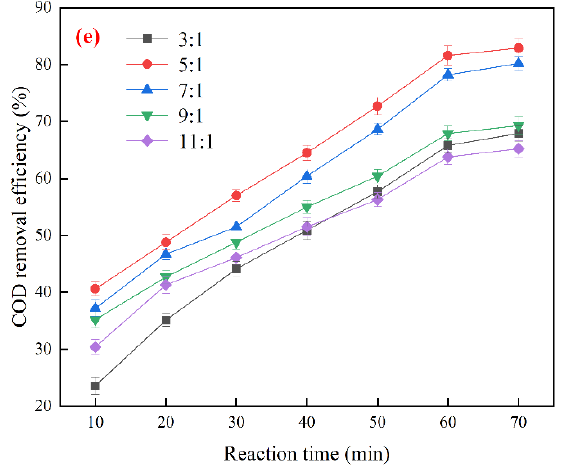
Figure 5. Effects of different conditions on COD removal efficiency: ( a ) reaction time, ( b ) pH, ( c ) ozone aeration, ( d ) catalyst filling rate, ( e ) reaction column height-diameter ratio.